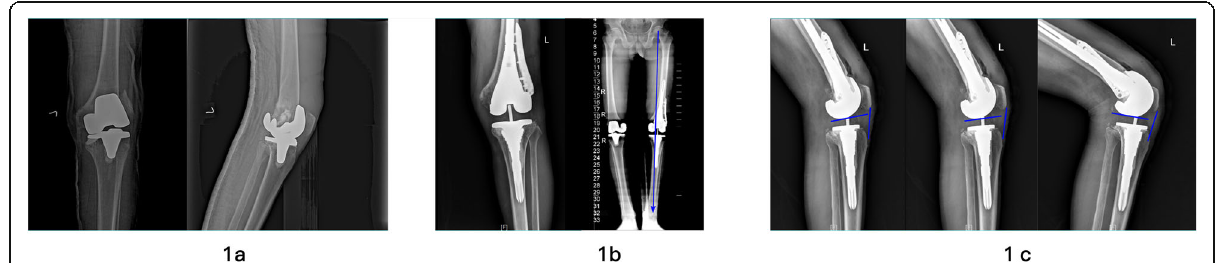
Fig. 1 a Radiographs of a 68-year-old male who underwent revision TKA for aseptic femoral loosening and distal femoral fractures associated with an AORI type 3 femoral defect. b Postoperative full-length standing anteroposterior radiographs demonstrated the the knee was well- aligned and prosthesis was well-fixed. c Lateral views of the knee revealed no patella